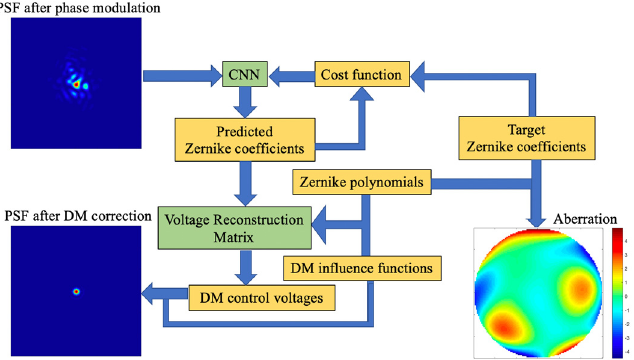
Figure 2. Working principle of the FQDPM-based CNN-AO.